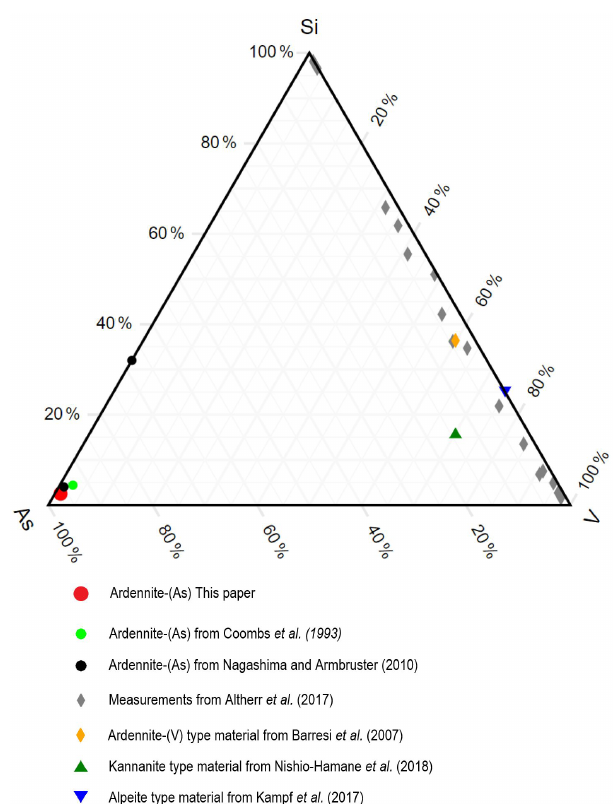
Figure 3. Ternary diagram showing the T 4 site occupancy in ar- dennite and related minerals from this paper and selected literature sources. The data for the samples from Altherr et al. (2017) may partly correspond to